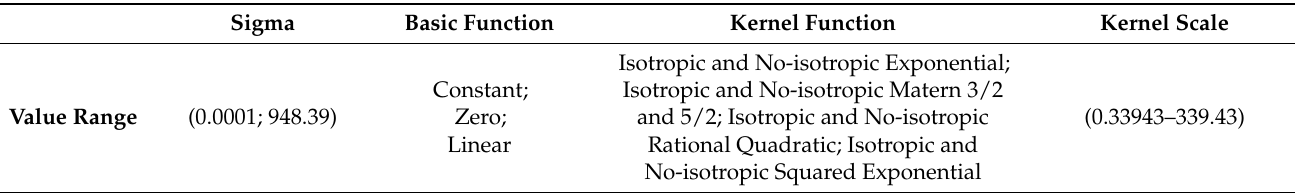
Table 7. Hyperparameters of the GPR